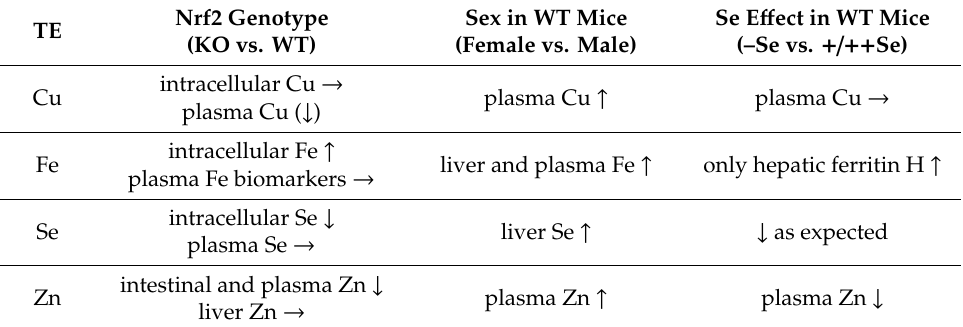
Se E ff ect in WT Mice (–Se vs. +/++ Se)